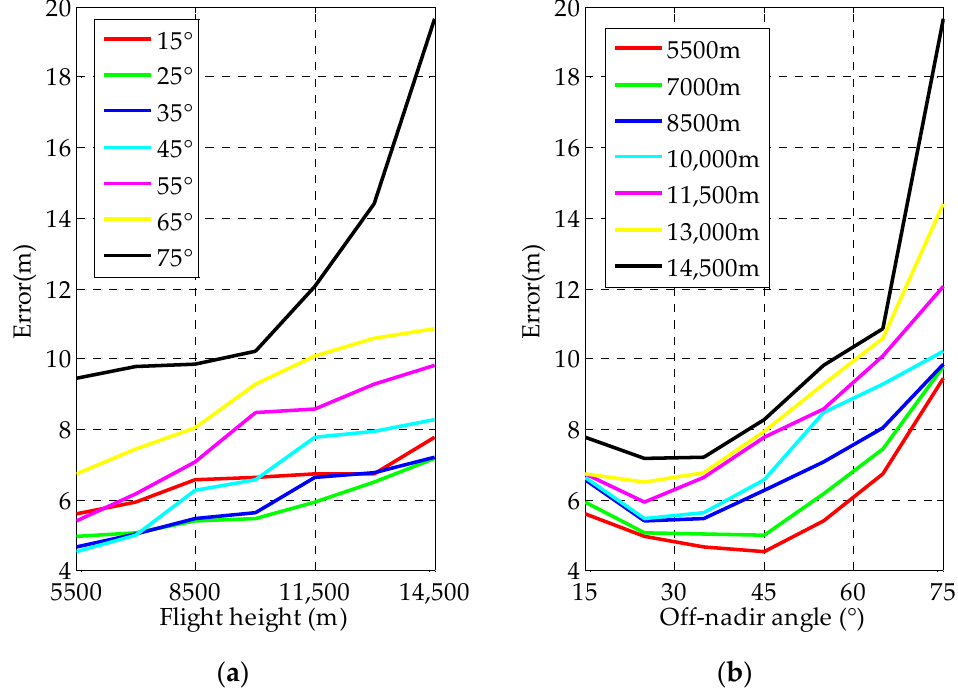
Figure 8. Flowchart of the proposed method. Influence of flight heights and off-nadir looking angle on geo-location: ( a ) Geo-location error curves with different flight heights when the off-nadir looking angle was changed from 15° to 75°; ( b ) Geo-location error curves with different off-nadir looking angles when the flight height was changed from 5500 m to 14,500 m.